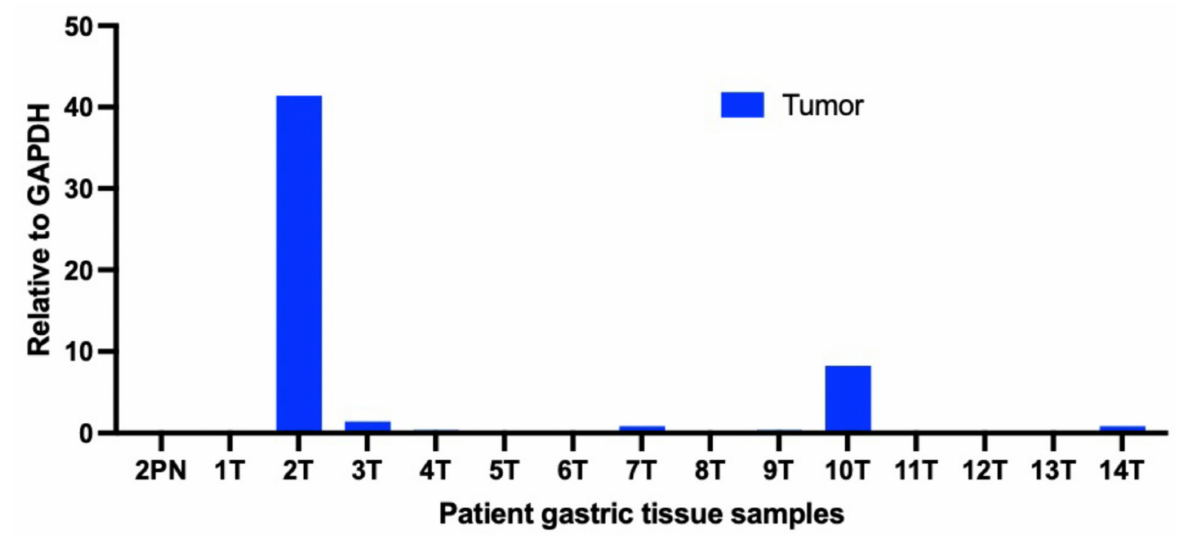
Figure 4. CXCL5 was overexpressed in the gastric biopsy of the case patient. CXCL5 expression in 13 other gastric biopsies is shown for comparison. CXCL5 expression was quantified via qRT-PCR and expressed relative to GAPDH using comparative cycle threshold calculations ( ∆ C T , Applied Biosystems). 2PN, paired normal control of case patient (2T); T, tumor gastric cancer